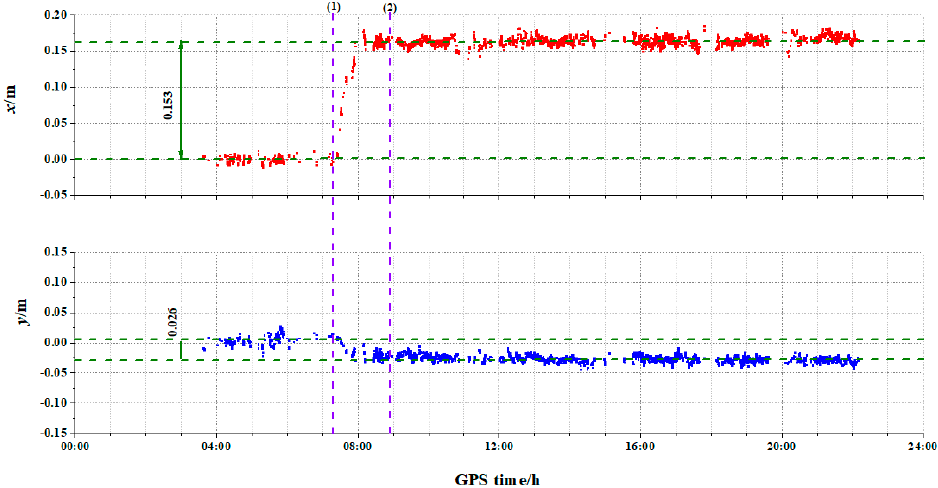
Figure 20. Real-time tower deflection of QBT1. The vertical line ( 1 ) represents the start moment of saddle pushing and ( 2 ) represents the end moment of saddle pushing. The deformation of the x- direction is shown in red and y is shown in blue.